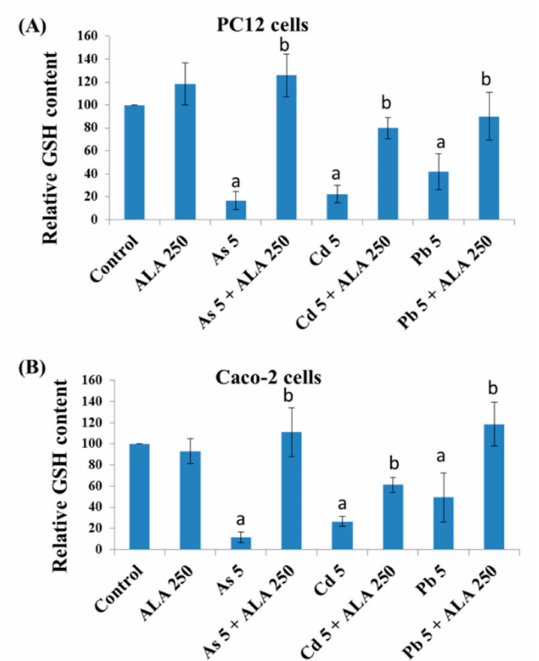
Figure 7. Intracellular levels of glutathione (GSH) upon exposure to toxic metals and/or ALA measured by the 5,5 (cid:48) -dithiobis-2-nitrobenzoic acid (DTNB) assay in ( A ) PC12 cells and ( B ) Caco- 2 cells. The values of the bars indicate the mean ± SEM ( n = 3). Here, “a” denotes a significant difference compared to the control group ( p < 0.05), and “b” denotes a significant difference compared to the associated metal group ( p <